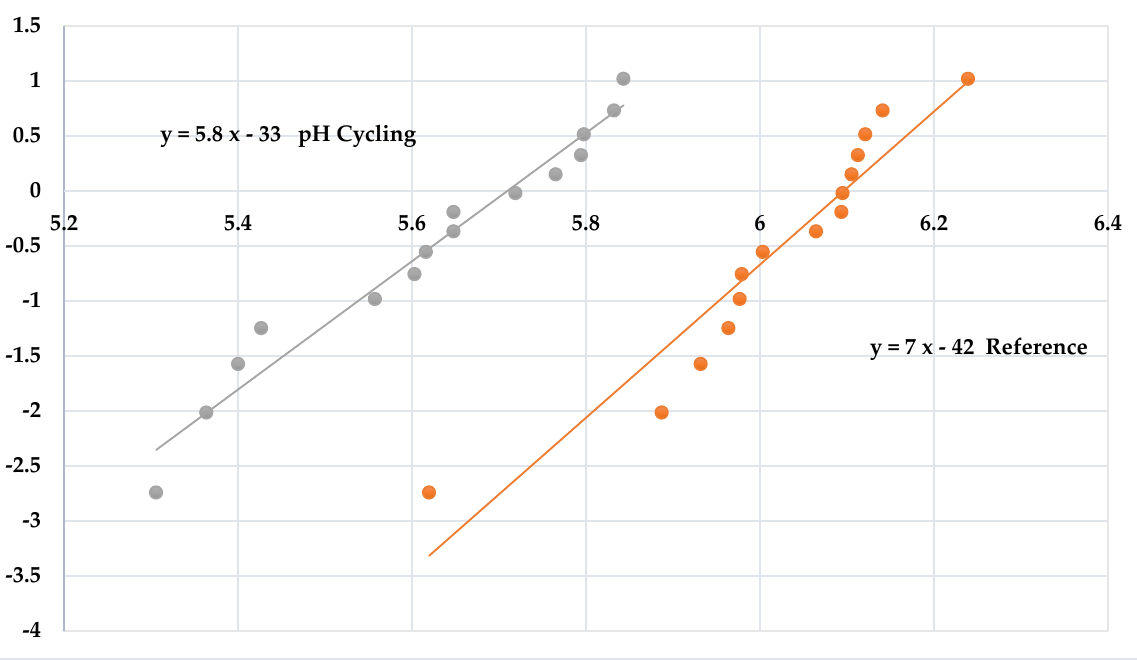
Figure 3. Weibull distribution comparison between pH cycling and reference (hydrated) groups (Ln Ln [1/(1 − F) vs Ln Strength]).